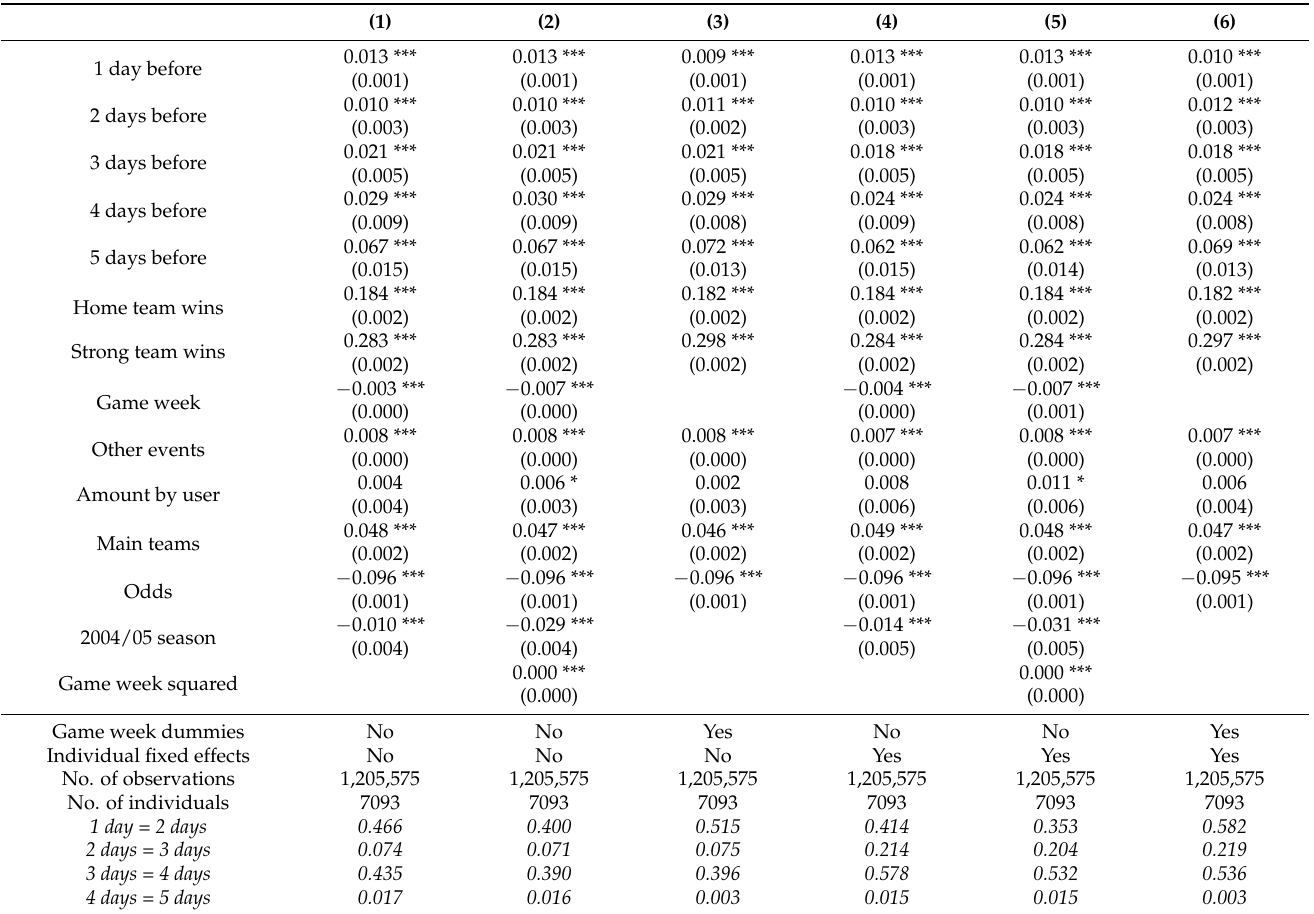
Table 5. The impact of betting distance: non-parametric